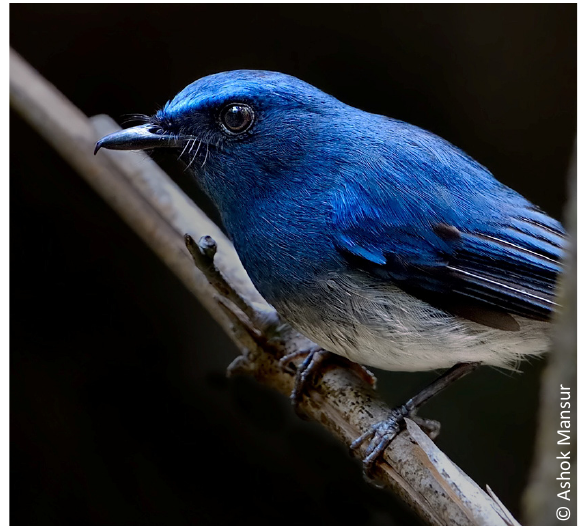
Image 5. White-bellied Blue Flycatcher Image 6. White-bellied